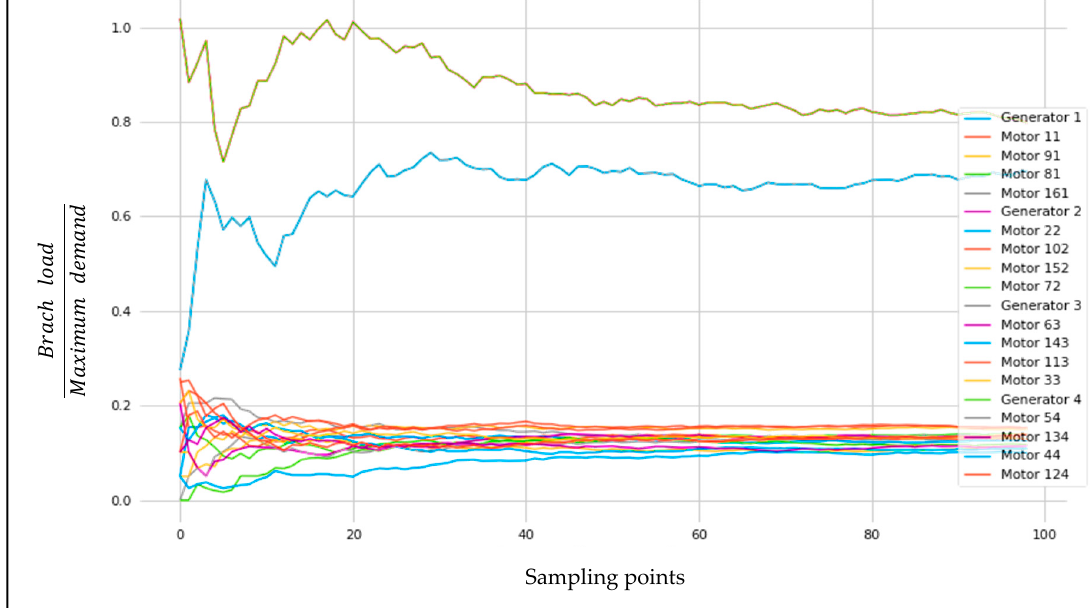
Sampling points Figure 12. Monte Carlo load average for NASA N3-X under the cruising Figure 12. Monte Carlo load average for NASA N3-X under the cruising condition.